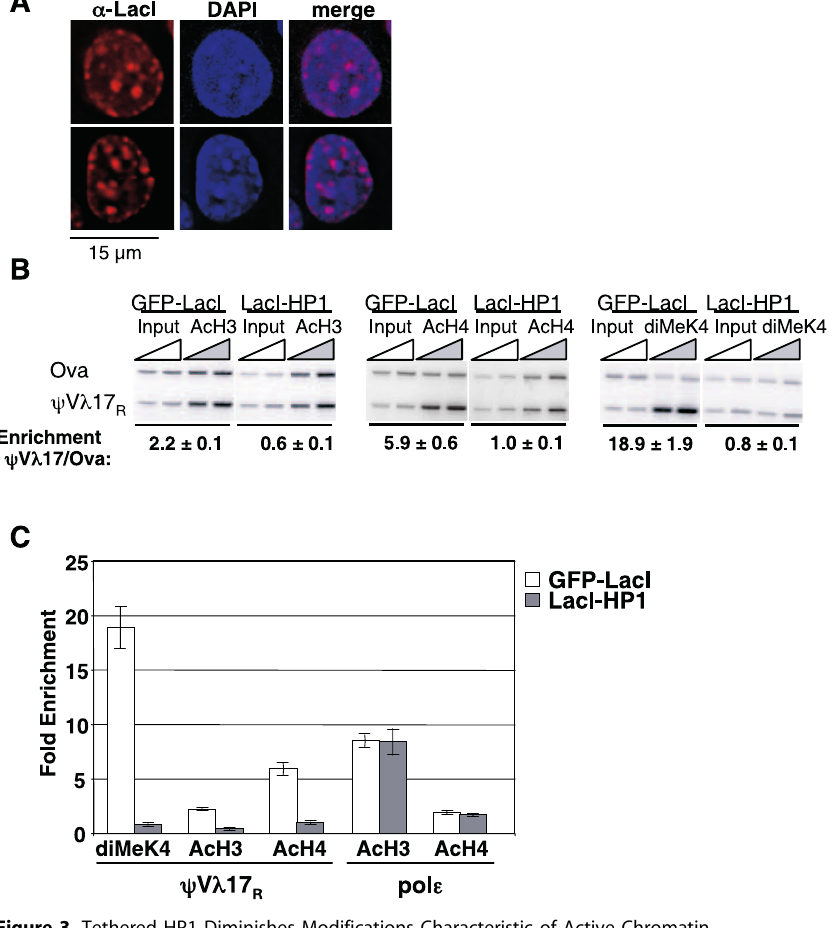
Figure 3. Tethered HP1 Diminishes Modifications Characteristic of Active Chromatin (A) Representative fluorescent images of single DT40 PolyLacO-V k R LacI-HP1 transfectants, stained with anti-LacI antibodies (left), DAPI (center), or merged image (right). (B) Enrichment of AcH3 and AcH4 at w V k 17 R in DT40 PolyLacO-V k R GFP-LacI and DT40 PolyLacO-V k R LacI-HP1 transfectants. Following ChIP, duplex PCR was carried out with Ova and w V k 17 R primers. Enrichment is expressed relative to the total DNA input control 6 standard deviation of four separate amplifications of increasing amounts of template DNA. (C) Histogram showing enrichment of AcH3 and AcH4 at w V k 17 R (from [B]) and the pol e promoter in DT40 PolyLacO-V k R GFP-LacI and DT40 PolyLacO- V k R LacI-HP1 transfectants. Bars indicate standard deviation.